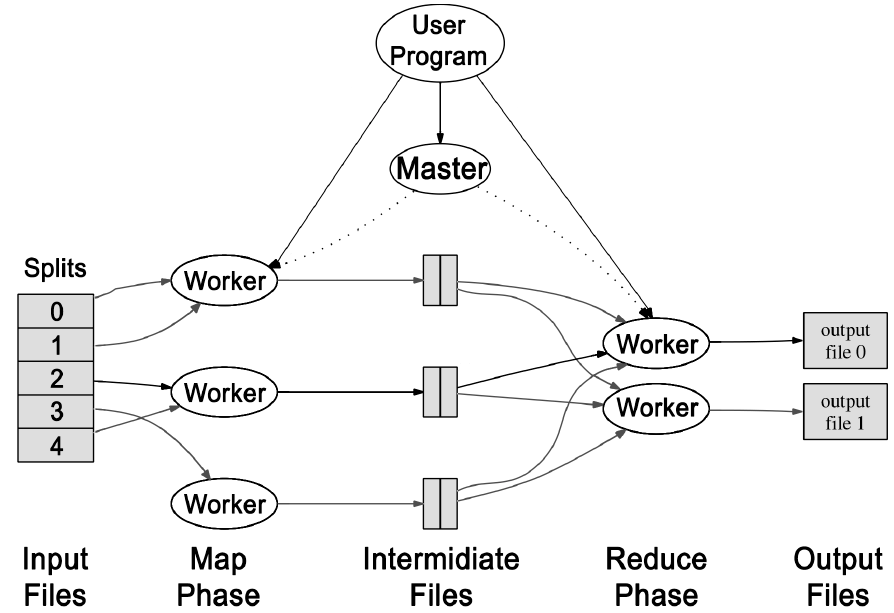
Figure 1. Map-Reduce Framework [1] .